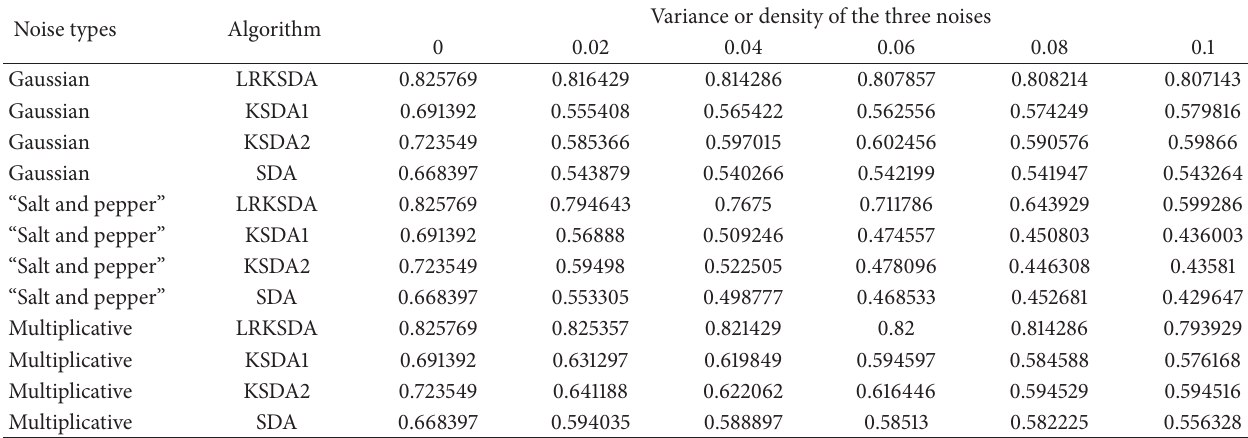
Table 4: Classification accuracy of different graphs with varying noise on Yale B